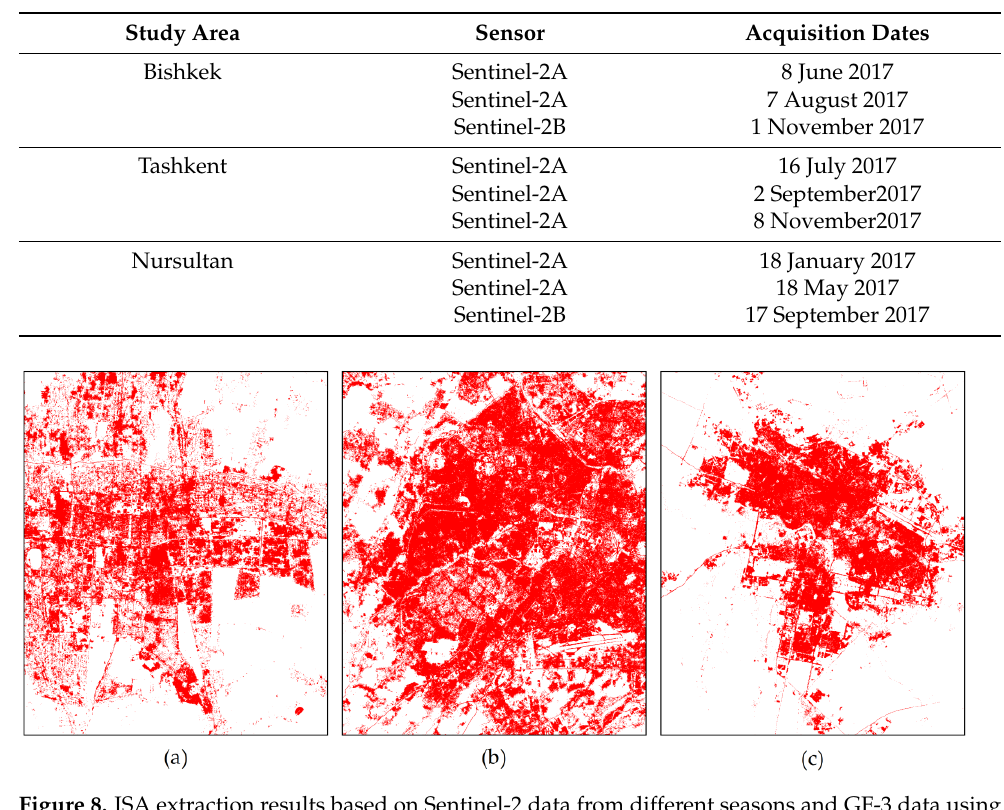
Figure 8. ISA extraction results based on Sentinel-2 data from different seasons and GF-3 data using the STDF method. Red indicates ISA. ( a ) Bishkek. ( b ) Tashkent. ( c ) Nursultan.